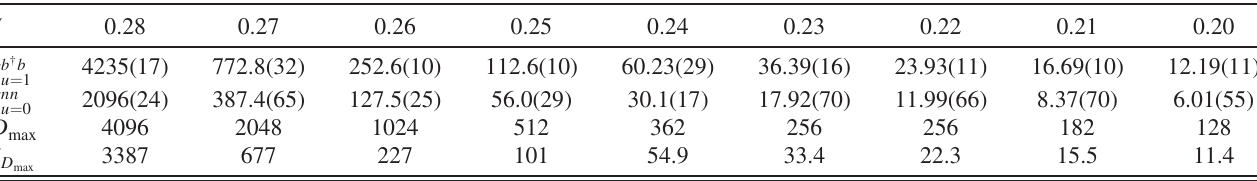
TABLE III. Extrapolated correlation lengths in the Bose-Hubbard model with unit filling, h n i ¼ 1 . We show the correlation lengths for h b † 0 b R i and h n 0 n R i . Notice that the correlation length for h n 0 n R i is approximately halved as compared to the one for h b † 0 b R i . Additionally, we show maximal bond dimension D used in the simulation and MPS correlation length for that D